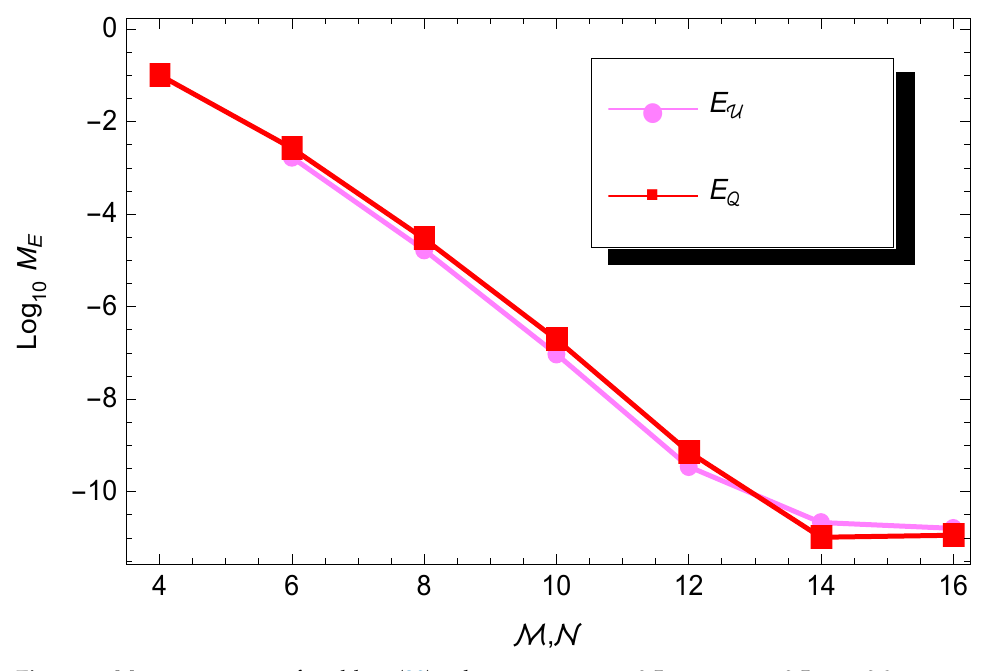
Figure 9. M E convergence of problem (30), where σ 1 = (cid:36) 1 = − 0.5, σ 2 = (cid:36) 2 = 0.5, ν =